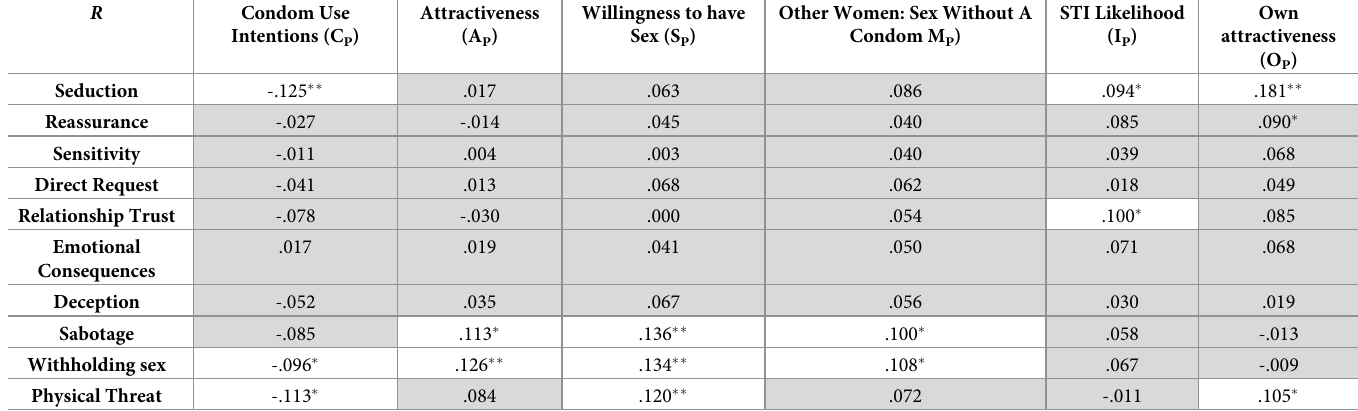
Table 5. Bivariate associations (Pearson’s r ) between 480 (df = 478) condom resistance tactics factors (left column) and their mean ratings of 20 women. Signifi- cance levels are indicated: � = p < 0.05, �� = p < 0.01, grey cells =